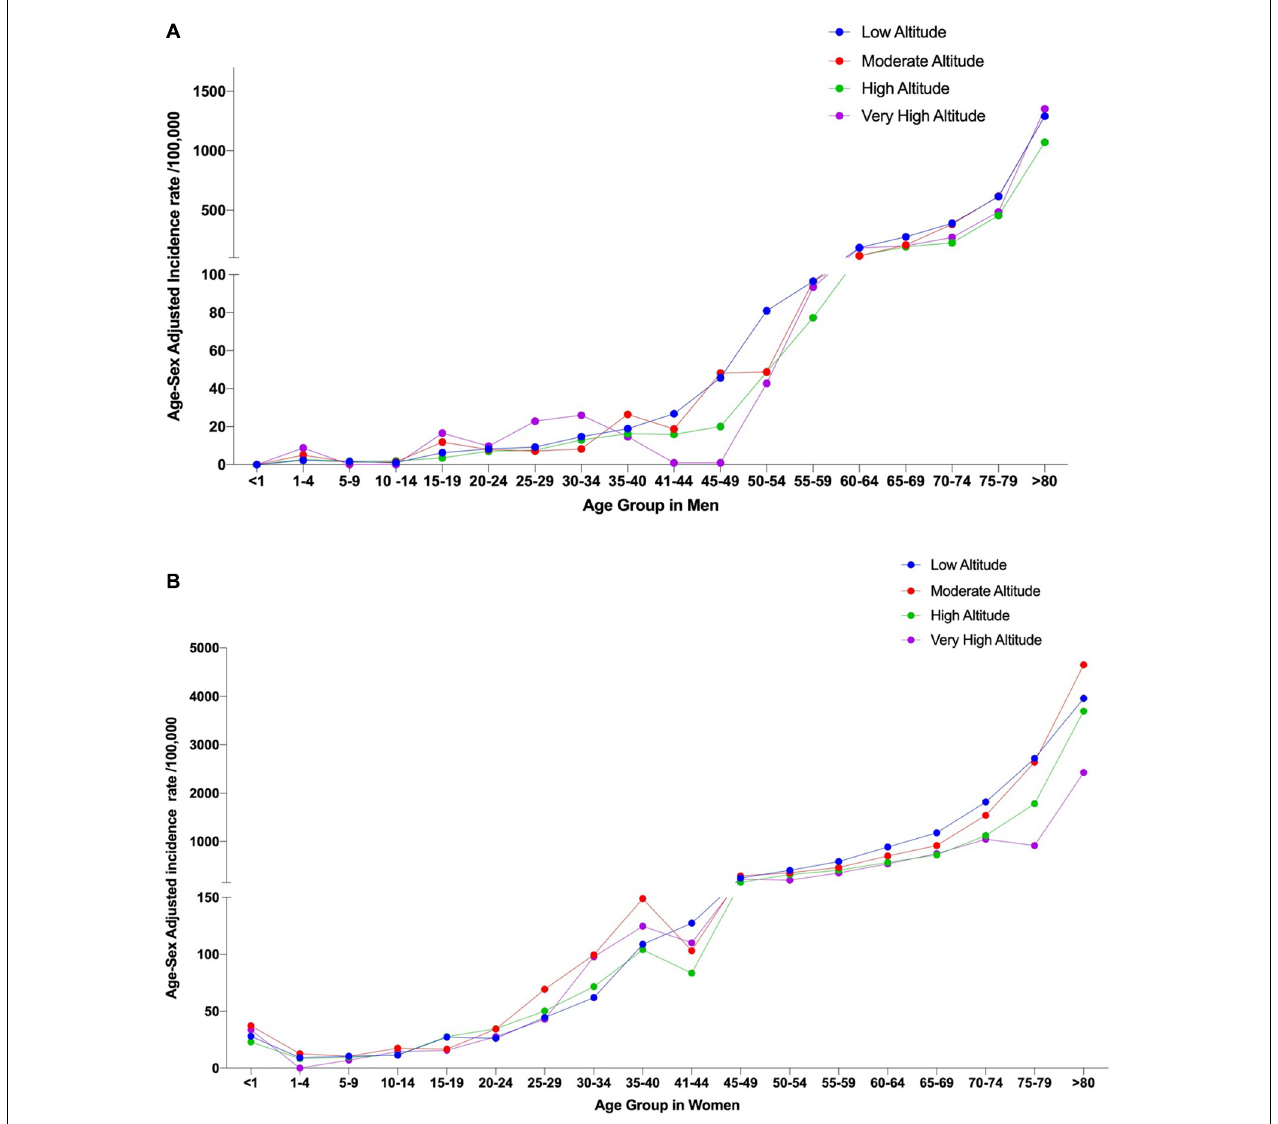
FIGURE 5 | Age-sex adjusted incidence rates due to stroke by age group using the four elevation categories. (A) Incidence rates in men at Low Altitude ( < 1,500 m), Moderate Altitude (1,500 − 2,500 m), High altitude (2,500 m − 3,500 m) and Very High altitude (3,500 m − 5,500 m) and (B) Incidence rates in women at Low Altitude ( < 1,500 m), Moderate Altitude (1,500 m − 2,500 m), High altitude (2,500 m − 3,500 m) and Very High altitude (3,500 m − 5,500